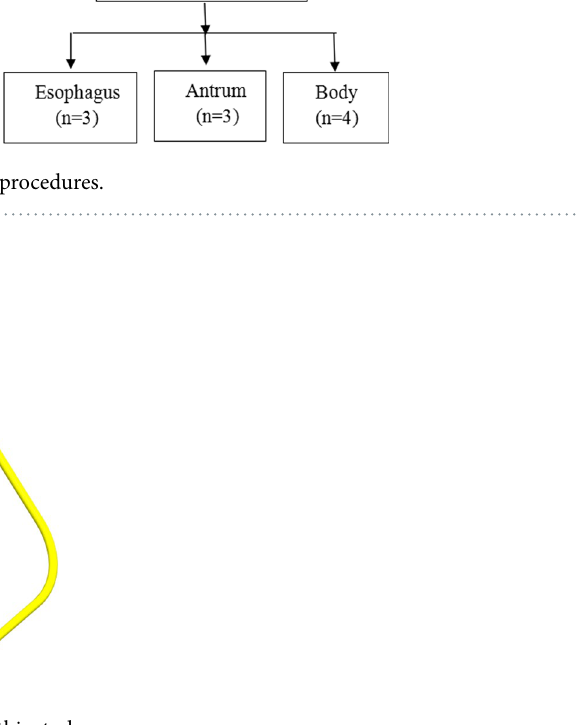
Figure 2. The novel bracing basket used in this